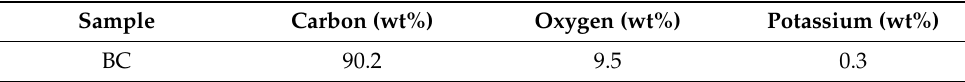
Figure 3. BSE image of BC. Table 1. EDS composition of BC.